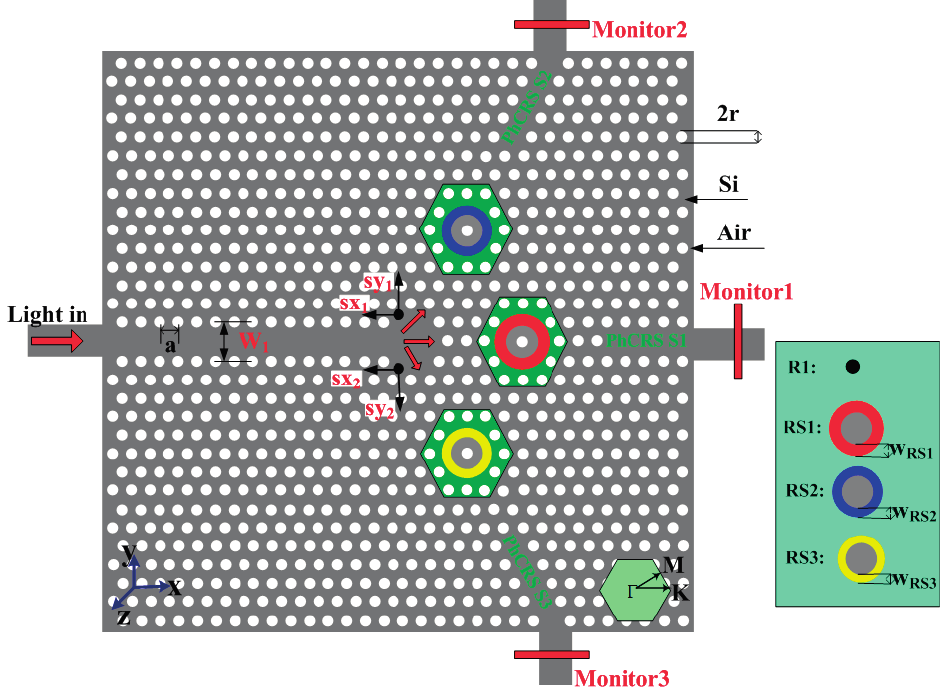
Figure 1. The schematic of nanoscale integrated PhC ring-slot sensors array (PhCRSSA). The air holes and ring-slot in green area served as functionalized area.